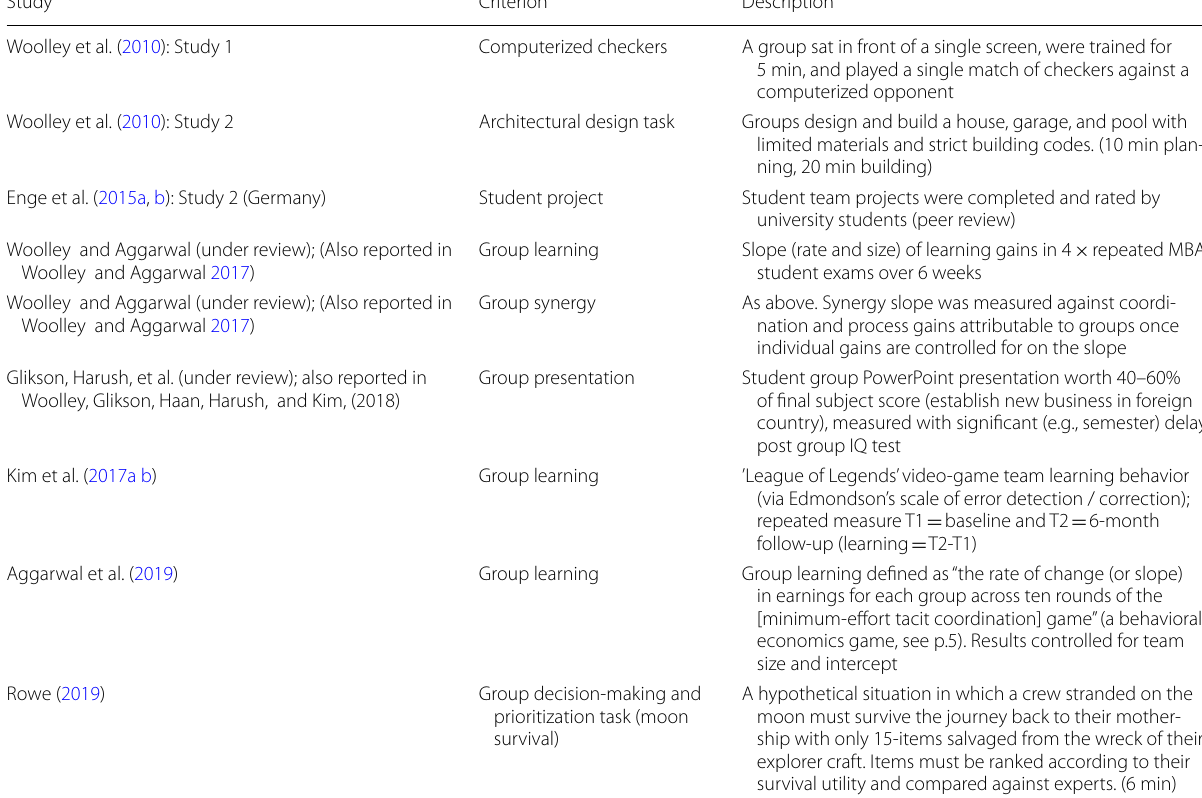
Table 4 External criterion tasks